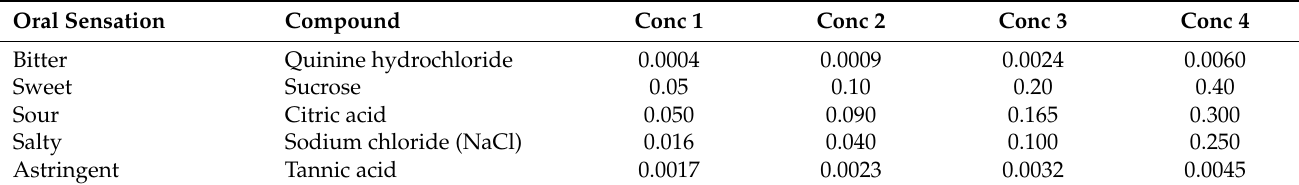
Table 1. Concentrations (g/mL) of solutions of four basic tastes and